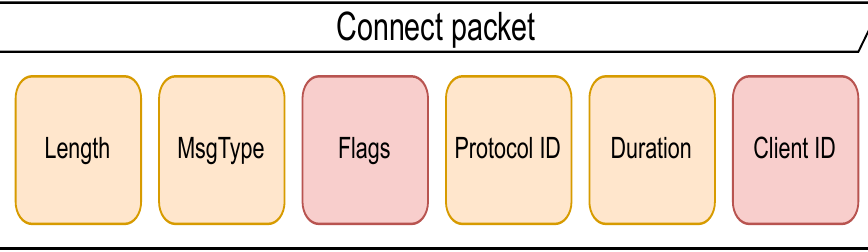
Figure 16. Connect packet format (spoofing connection).